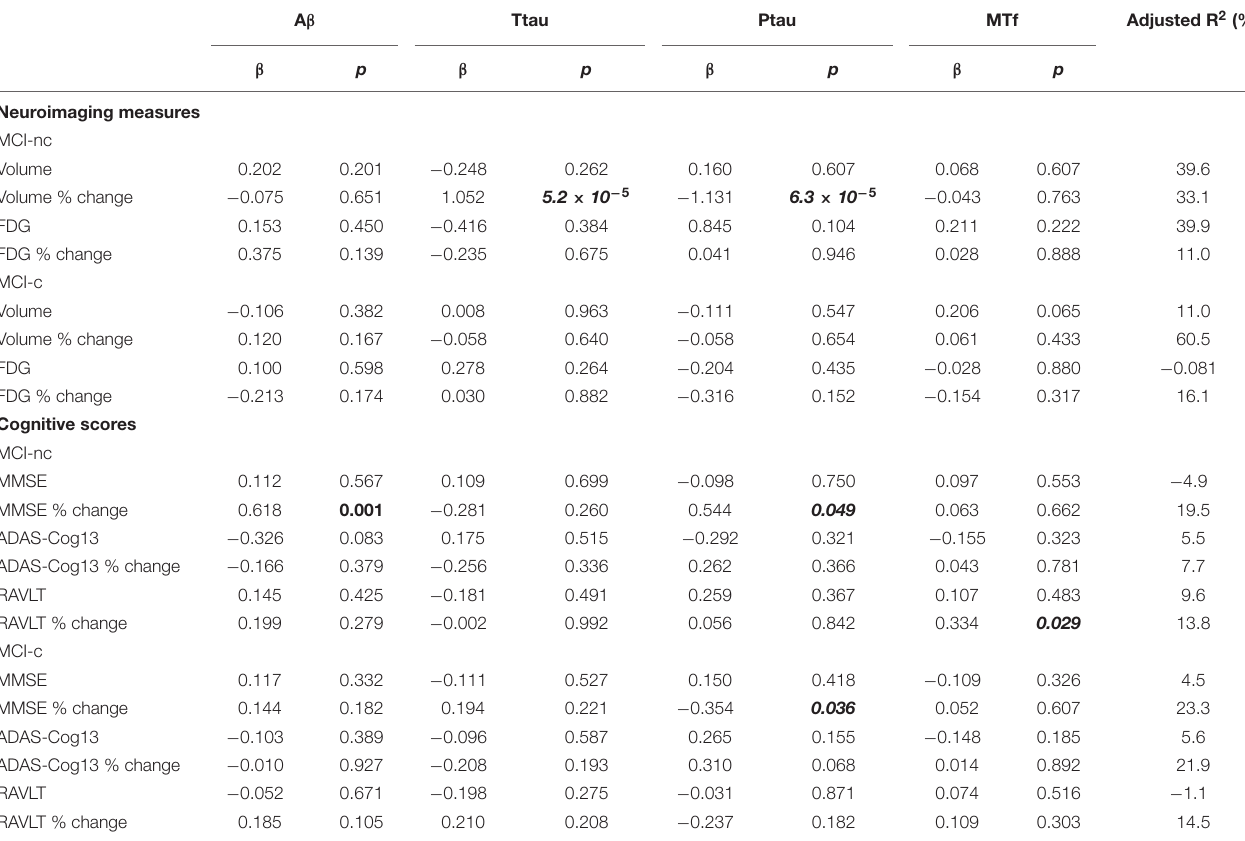
TABLE 6 | Association of CSF A β , total tau (ttau), phosphorylated tau (ptau), and melanotransferrin (MTf) with hippocampal neuroimaging measures and cognitive scores in MCI non-converters (MCI-nc) and converters (MCI-c) to Alzheimer’s Disease ( Supplementary Figures 5 , 6 ). A